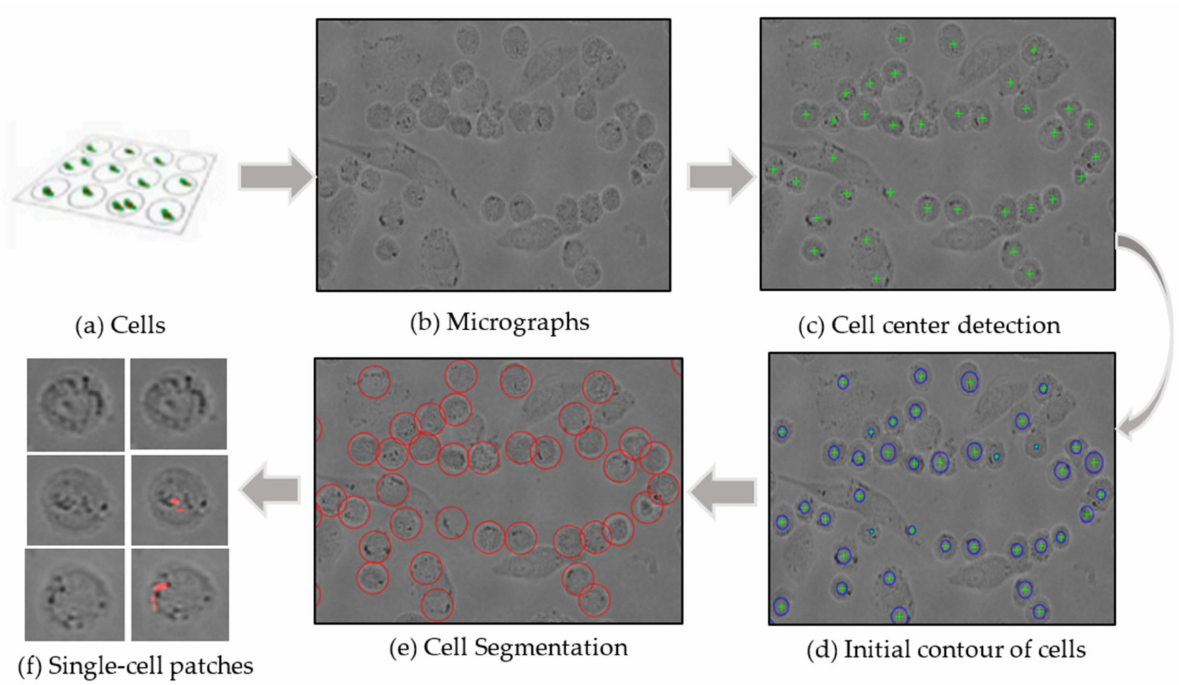
Figure 3. The Automatic detection process for THP-1 cell images.